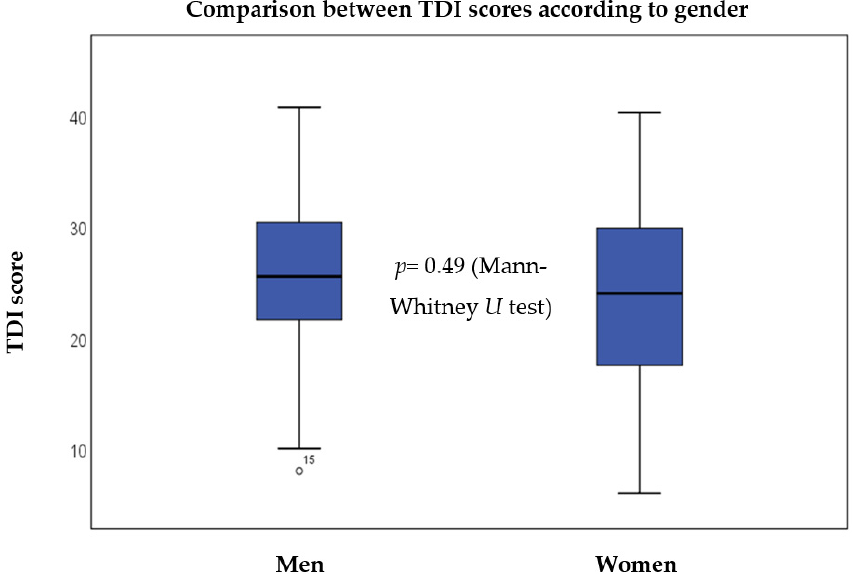
Figure 1. Comparison between the TDI values according to gender. The boxes represent the middle 50% of the data, and the whiskers represent the upper and lower 25%. The black line inside the boxes represents the median value. Differences were analysed using the Mann–Whitney U test ( p < 0.05 *). TDI = Threshold, Discrimination, Identification.